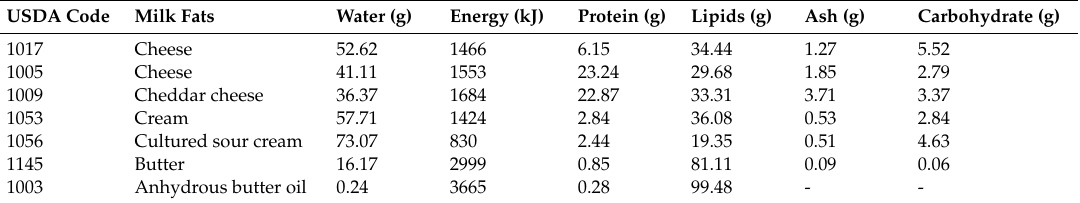
Table 2. Proximate nutritional information of main milk lipid